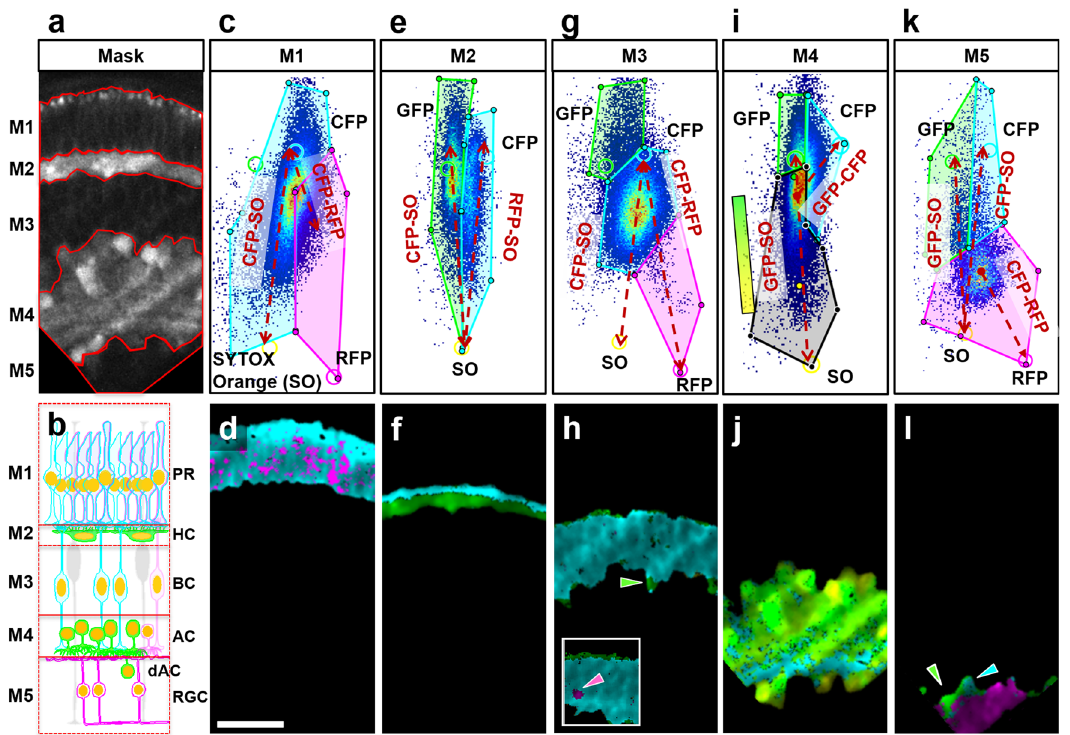
Fig. 4 Hyperspectral cellular fi ngerprinting reveals zebra fi sh retinal composition. a Fluorescence intensity image showing the region of the retina used for segmentation phasor analysis; red lines indicate masks (M1 – M5) for the cell layers of the SoFa fi sh retina. b Scheme of the different cell types and layer organization of the zebra fi sh retina at this embryonic stage. c M1 phasor plot identifying the linear combination between CFP and SYTOX Orange (SO) (labeled CFP-SO) and a group of voxels with a fraction of CFP/SO plus RFP (labeled CFP-RFP). d Pseudocolored image representing the voxels selected inside the polygons. The pattern corresponded well with the expected high expression of CFP and low expression of RFP in the PR. e M2 phasor plot identifying two linear combinations, CFP-SO and GFP-SO. Polygon voxel selections highlight ( f ) CFP expressed in the upper boundary of the HC layer in addition to strong GFP expression from HC. g M3 phasor plot showing a big voxel cluster at the center between all components, associated with a linear combination of CFP and SO (labeled CFP-SO) marked with the cyan polygon. h The few voxels selected by the green polygon identi fi ed an amacrine cell (green arrowhead) of the adjacent layer (HC), showing the high spectral sensitivity of the phasor plot in each voxel. Additional weak expression of GFP and RFP was detected in this layer as well (green and magenta polygons), visible in some areas (inset, magenta arrowhead). i M4 phasor plot identifying the linear combination of GFP and SO highlighted with a black polygon and colored with a gradient color scheme (green-yellow) labeled as GFP-SO. This layer included a small group of voxels towards the CFP location, identi fi ed with the cyan polygon. j The pseudocolored image showed that the GFP-SO gradient corresponded well to the expected expression of GFP in amacrine cells, together with the nuclear SO stain. The cyan region highlighted a group of voxels at the bottom of the pseudocolored image, associated with axons of BP cells expressing CFP. k M5 phasor plot identifying a main cluster of voxels associated with a linear combination of RFP/SO highlighted by the magenta polygon. Two more groups were observed in this layer with either GFP or CFP and different fractions of SO (green and cyan polygons). l The pseudocolor image revealed that the magenta polygon selection corresponded to RGC, while the green polygon selection was consistent with displaced amacrine cells (dAC) (green arrowhead), and the cyan polygon selection with BP neurites (cyan arrowhead). Scale bar, 25 µ